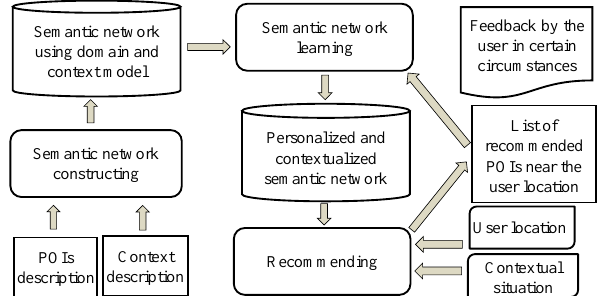
Figure 1. The architecture of the proposed context-aware tourism recommender system